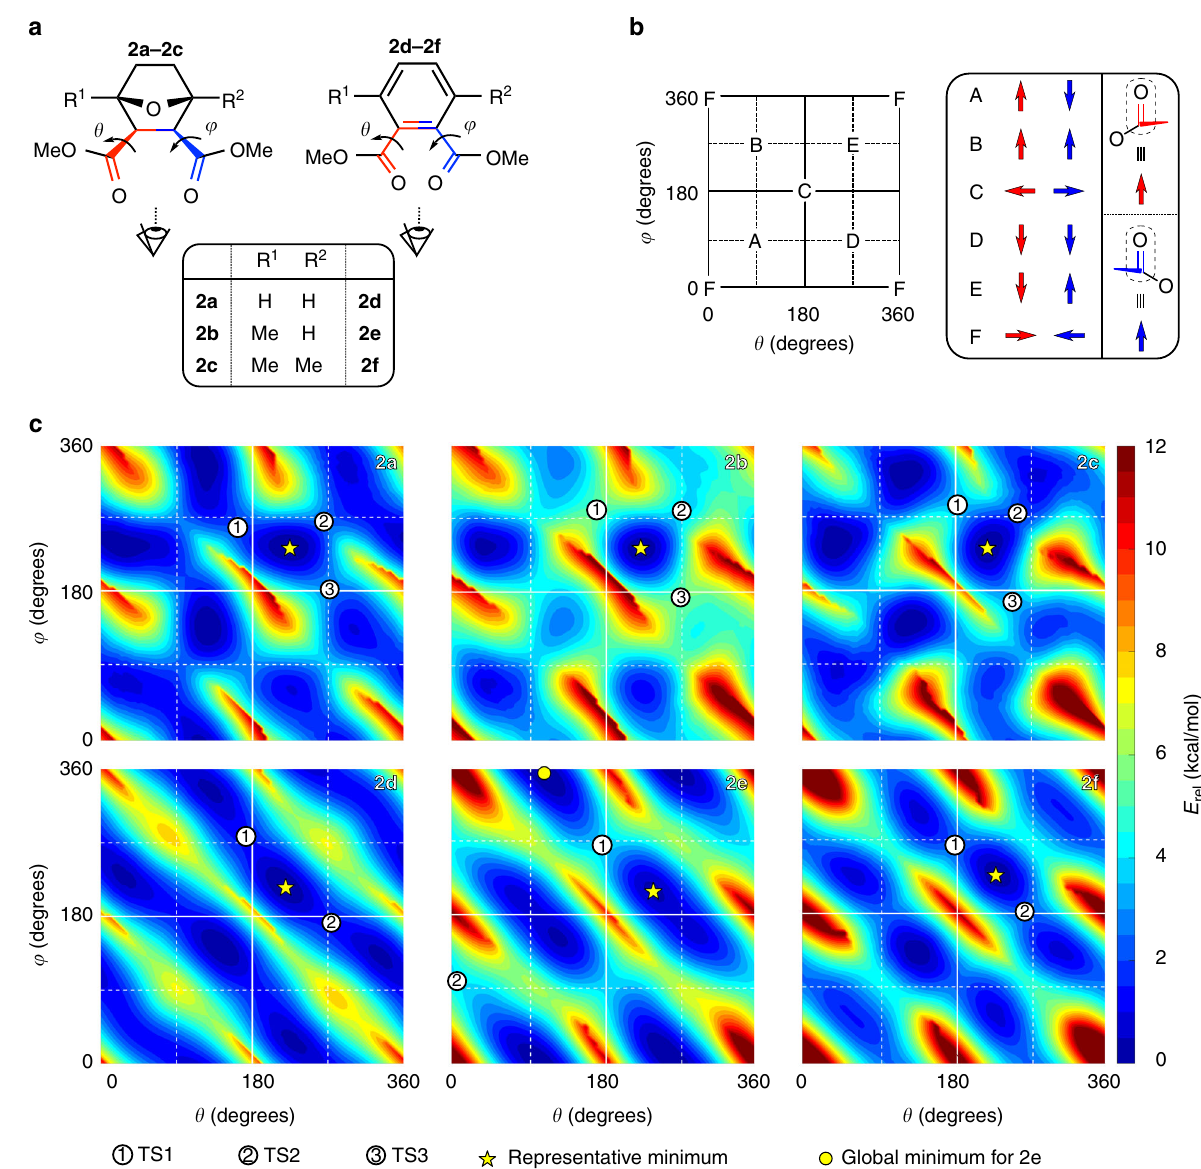
Fig. 3 Ramachandran-type analysis. a Model compounds for the tricyclic ( 2a – 2c ) and phthalic ( 2d – 2f ) anhydride-based polyesters considered in this work. The bonds used to specify the θ and φ dihedral angles are delineated in red and blue, respectively, with the corresponding perspectives de fi ned above. b Graphical legend illustrating the relative orientations of the two carbonyl groups corresponding to a given set of θ and φ dihedral angles. Red and blue arrows are used to depict the orientation of the left and right carbonyl groups, respectively. For example, conformation A (with dihedral angles given by θ = 90° and φ = 90°) corresponds to a structure with the left carbonyl group orientated upward and the right carbonyl group orientated downward. c Ramachandran-type plots depicting the full 2D PES corresponding to dihedral rotations about θ and φ for each of the polyester model compounds ( 2a – 2f ). Select stationary points on each PES include a representative minimum (gold star) and its most accessible neighboring transition states (circled numbers), the structures and energetics of which will be showcased in Fig. 5. The gold star corresponds to the location of the global minimum for all cases except 2e , where the global minimum (with an energetic separation of ~0.36 kcal/mol) is indicated with a gold circle (Supplementary Discussion